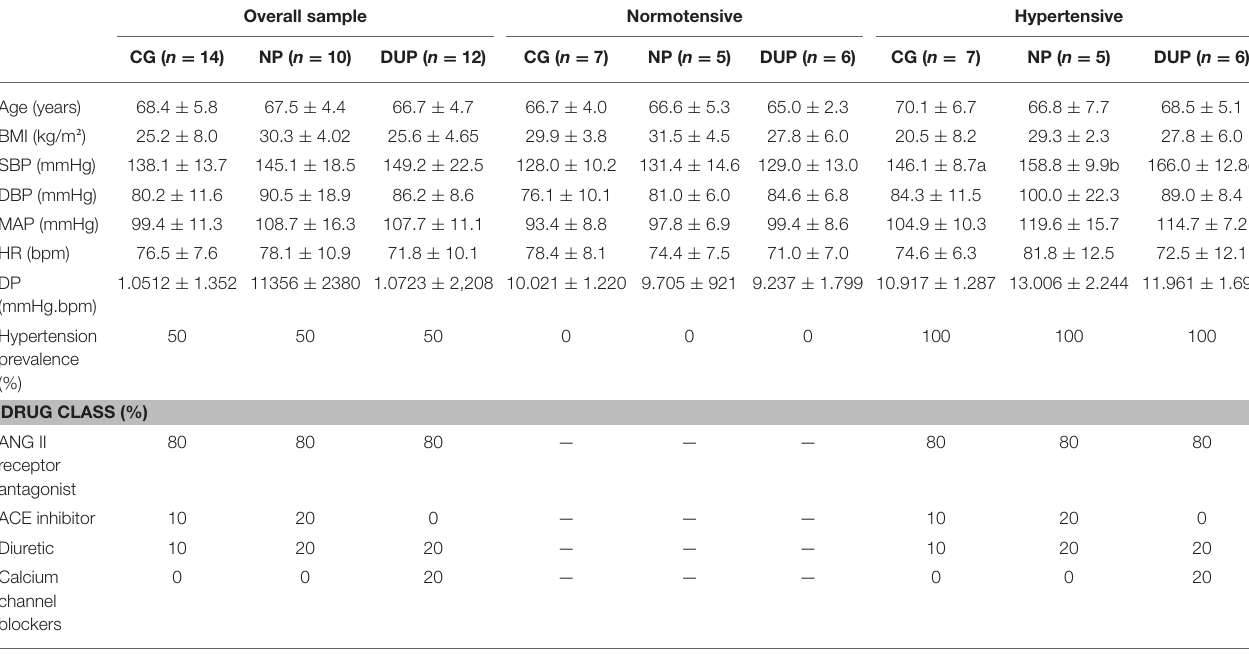
TABLE 1 | Comparison between the groups in relation to morphological and cardiovascular variables. Overall